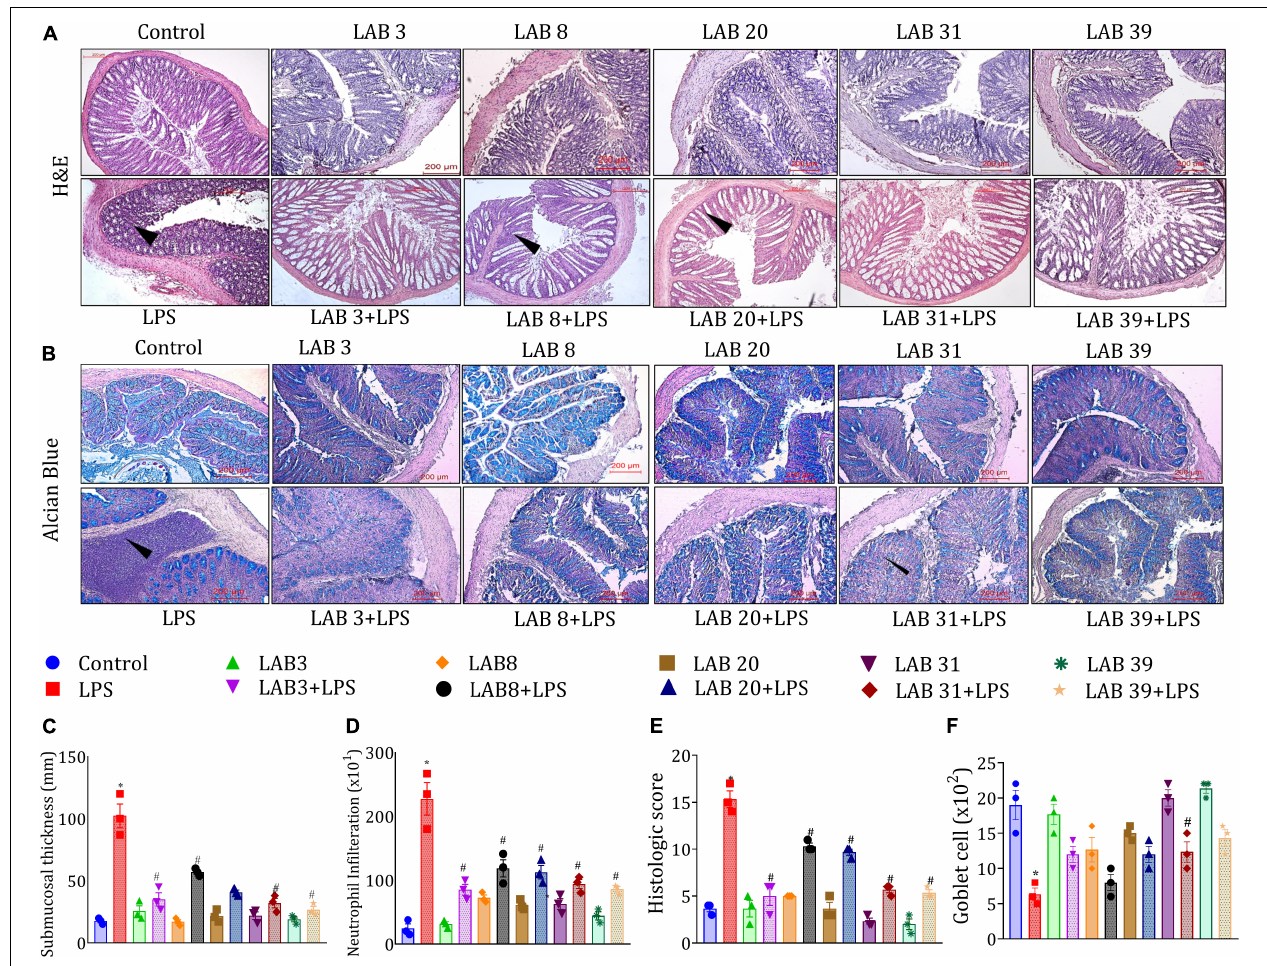
FIGURE 5 | Effect of LAB supplementation on the colon architecture: (A) Hematoxylin–eosin; (B) alcian blue staining images; (C) submucosa thickness; (D) neutrophil infiltration; (E) colon histologic score; and (F) goblet cell. Data were analyzed using one-way ANOVA with Tukey’s post hoc test ( p ≤ 0.05). *Significant relative to control; #significant relative to the LPS group ( N = 3); (arrows indicate the neutrophil infiltration; r : 200 µ m,